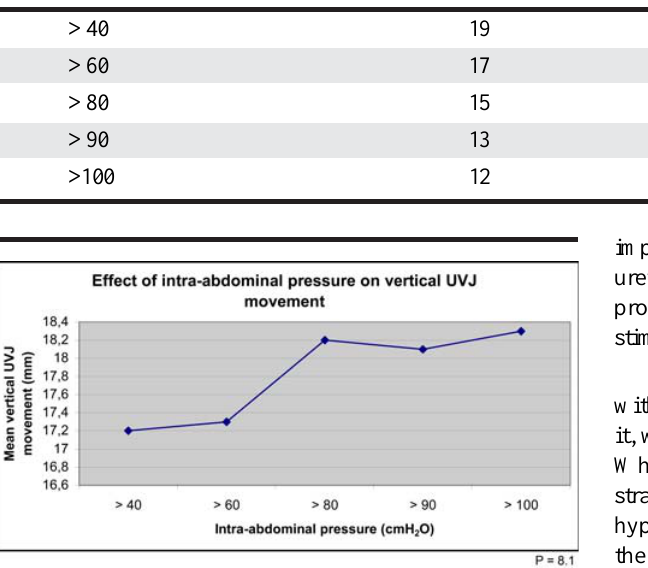
TABLE 5 - The impact of IAP on PUL of women with SUI as assessed by perineal ultrasound with a barely empty bladder. IAP